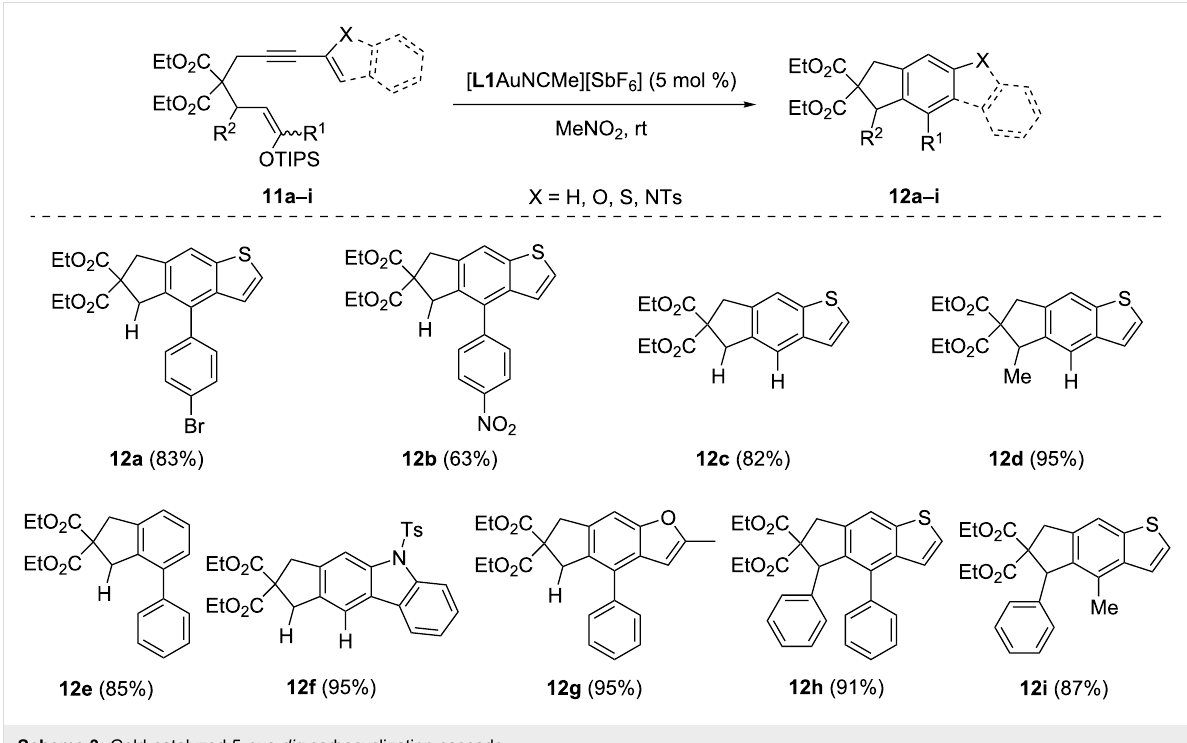
Scheme 3: Gold-catalyzed 5- exo - dig carbocyclization cascade.